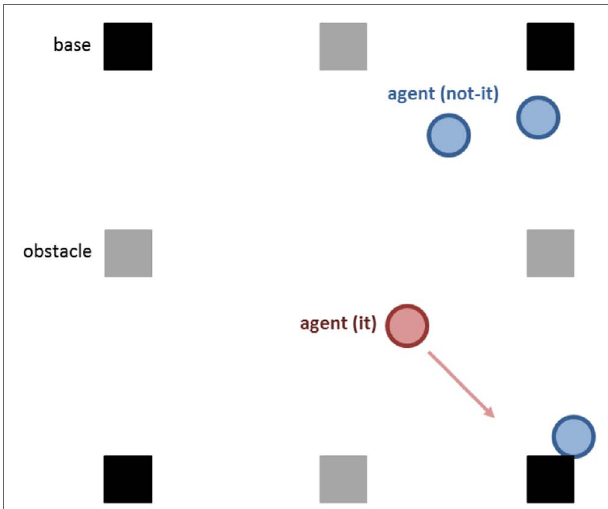
FIGURE 1 | Diagram of a Tag game environment, containing bases (darker squares), obstacles (lighter squares), and agents (circles) playing the game . Both kinds of Tag players are represented, one It player and three non-It